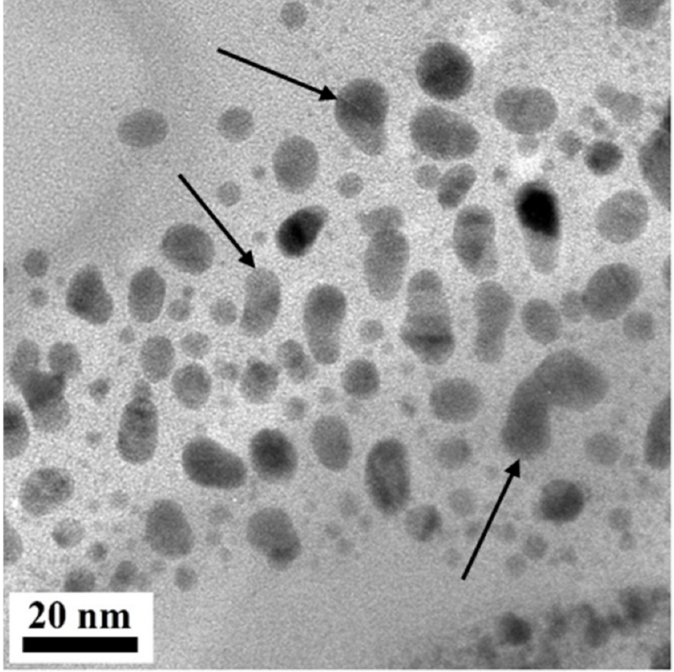
Figure 8. TEM bright-field image of a cross-sectioned Pt/AAO catalyst after 530 h of H 2